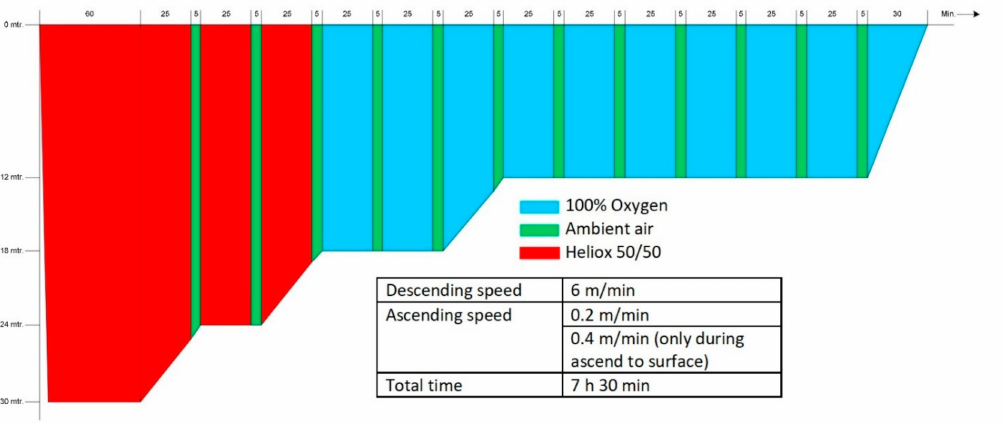
Figure A1. Schematic demonstration of the COMEX-30 recompression table used in this study